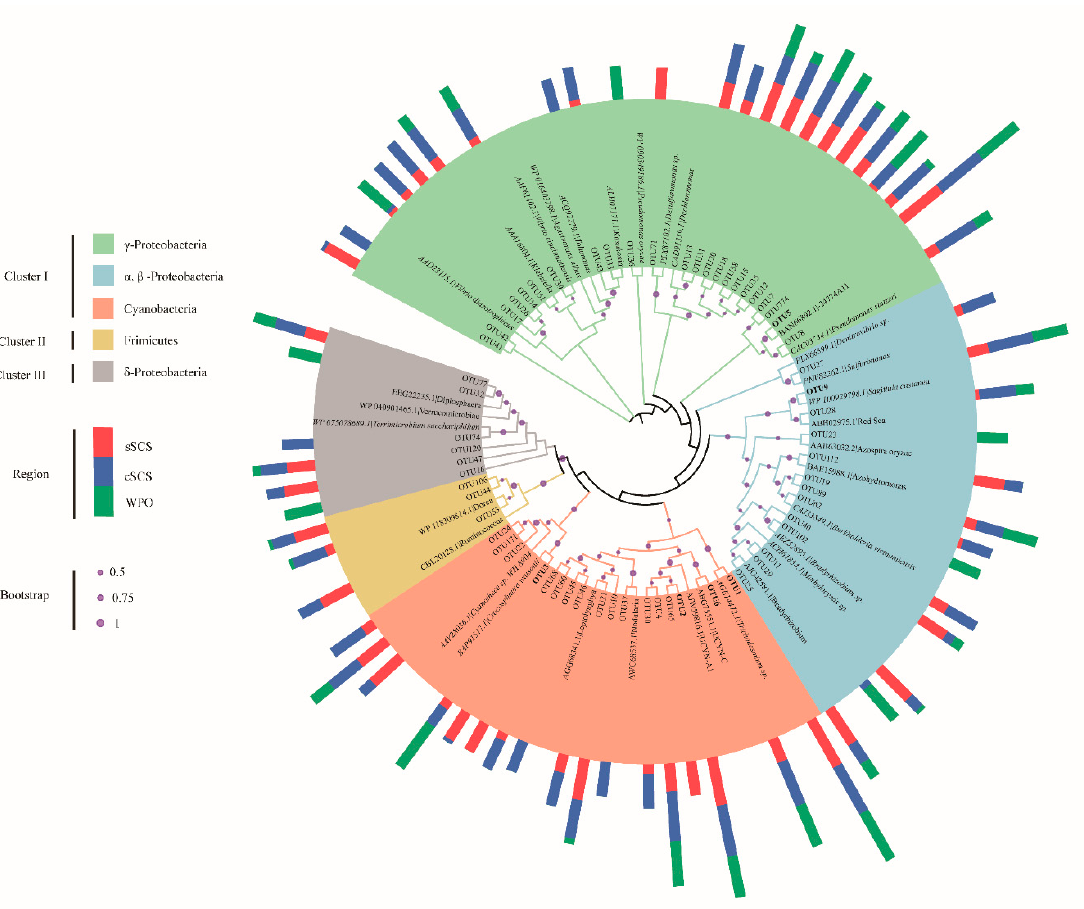
Figure A2. Maximum-likelihood phylogenetic tree is structured with nifH amino acid sequences in this study. Representative OTU sequences were indicated in boldface. The multi-bar shows the relative abundances of OTU sequences (log10) from different regions. Bootstrap resampling was performed 1000 times and its values higher than 50% are shown.